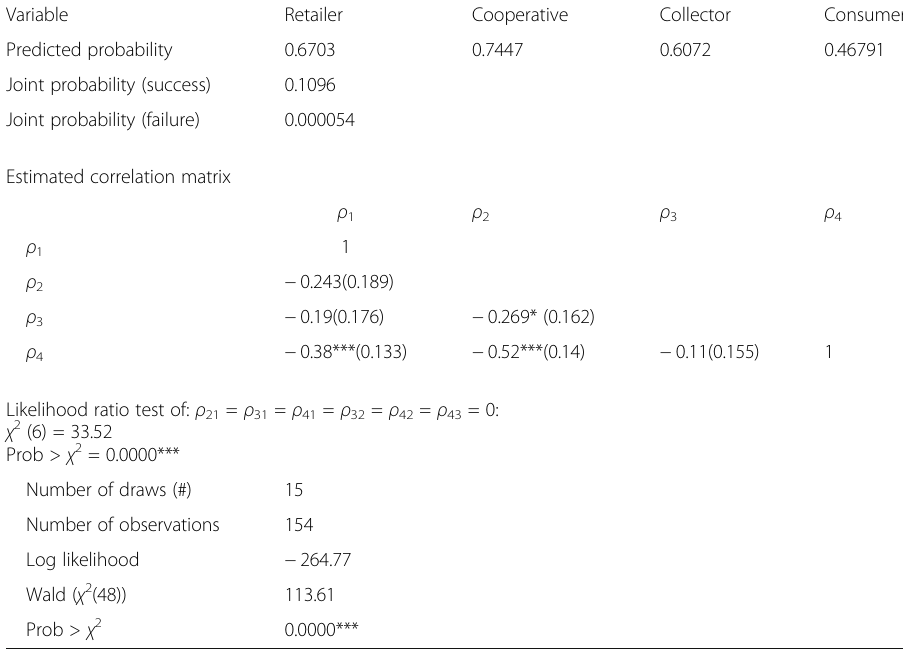
Table 4 Overall fitness, probabilities, and correlation matrix of the market outlets from the MVP model